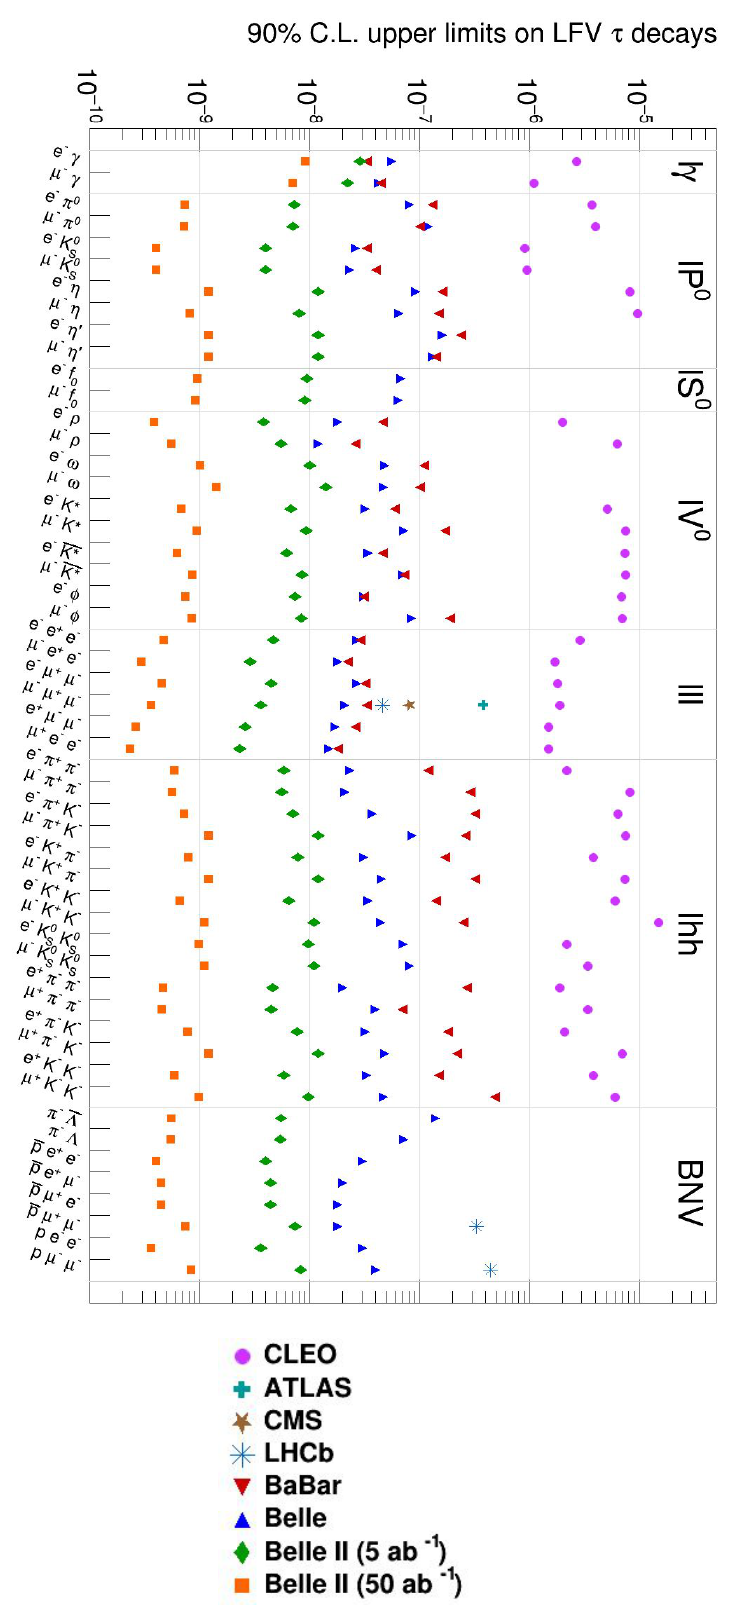
Figure 7. Current status of observed upper limits at CLEO, B A B AR , Belle, ATLAS, CMS, and LHCb experiments [92] and projections of expected upper limits at the Belle II experiment [40].